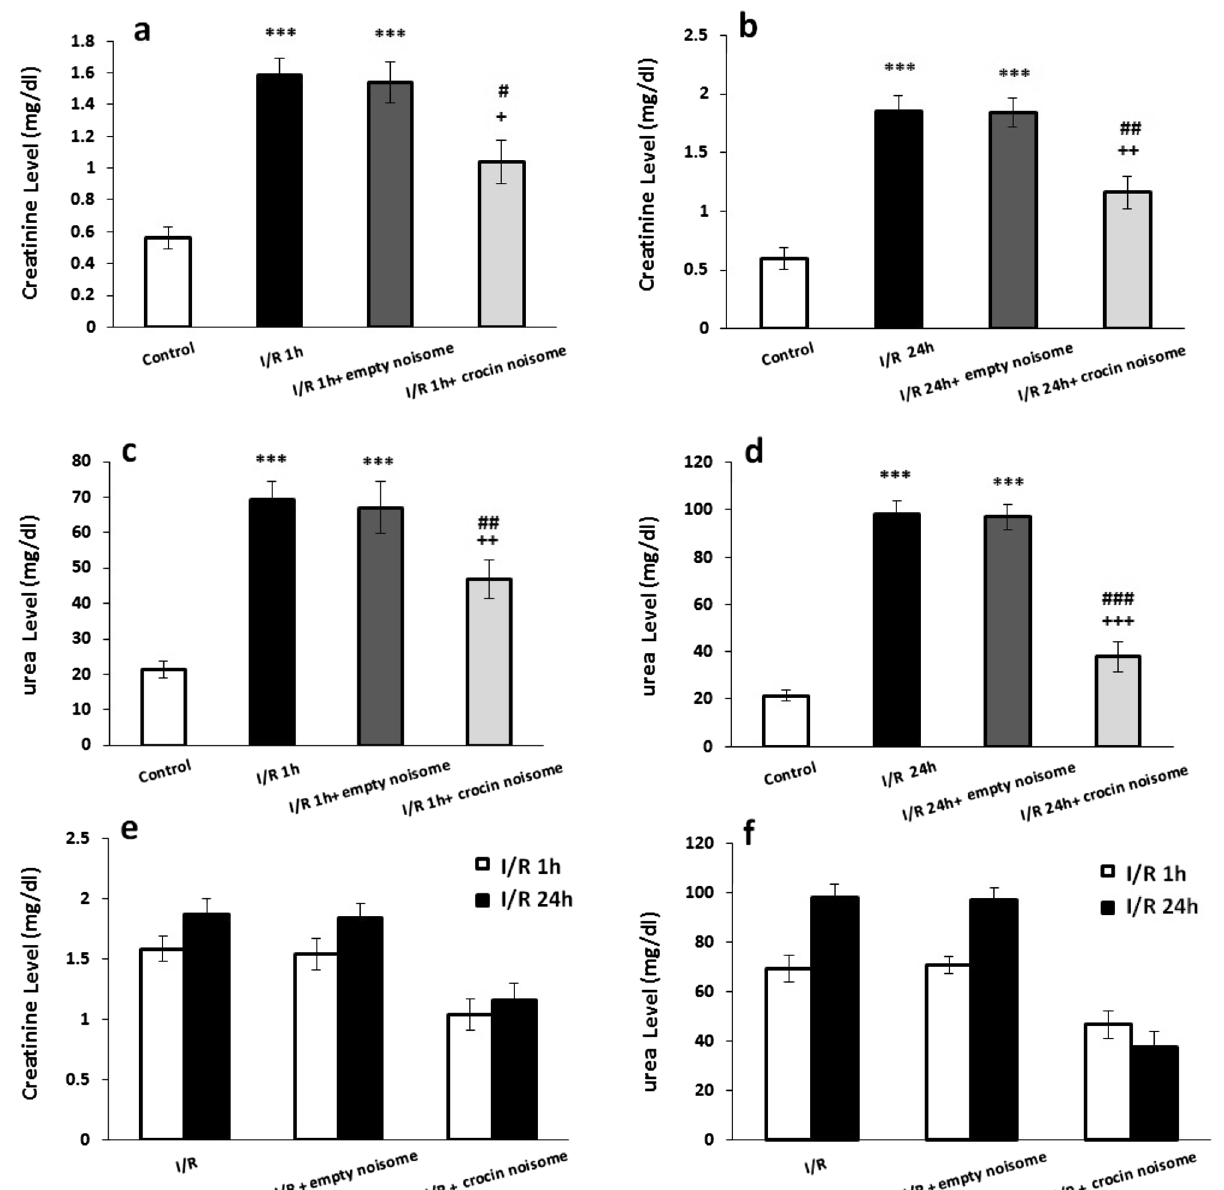
Figure 4. The effect of crocin-loaded nanoniosomes on ( a ) 1 h after I/R-induced changes in creatinine serum level, ( b ) 24 h after I/R-induced changes in creatinine serum level, ( c ) 1 h after I/R-induced changes in urea serum level, ( d ) 24 h after I/R-induced changes in urea serum level, ( e ) comparison ischemia-induced changes followed by 1 h and 24 of reperfusion in creatinine serum level and ( f ) comparison ischemia-induced changes followed by 1 h and 24 of reperfusion in urea serum level. Data presented as mean ± SEM. ***P < 0.001 and versus control group; + P < 0.05, ++ P < 0.01and +++ P < 0.001 versus I/R group; # P < 0.05, ## P < 0.01 and ### P < 0.001 versus I/R + empty niosome